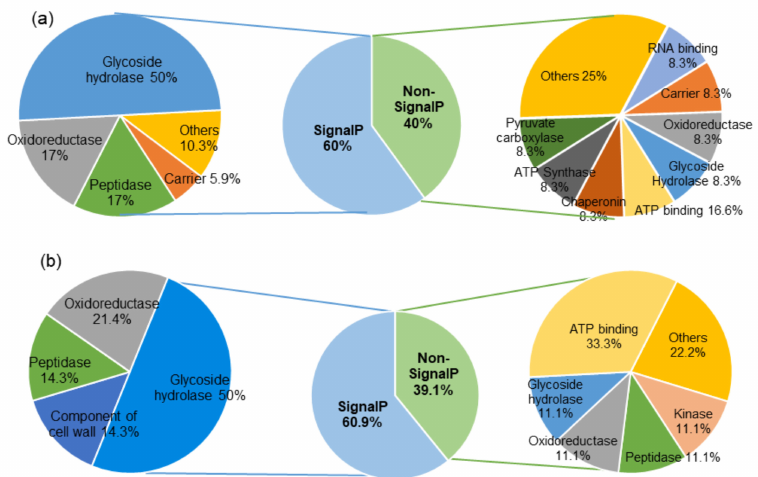
Figure 5. Proteome of the Penicillium rubens strain 212 crude extract after growth for seven days in Morton’s medium (CE7) ( a ) and the high molecular mass protein fraction (HMM-PF) ( b ) identified in predictive genome of PO212 by nLC-MS / MS. The identified proteins were distributed according to their corresponding function (according to